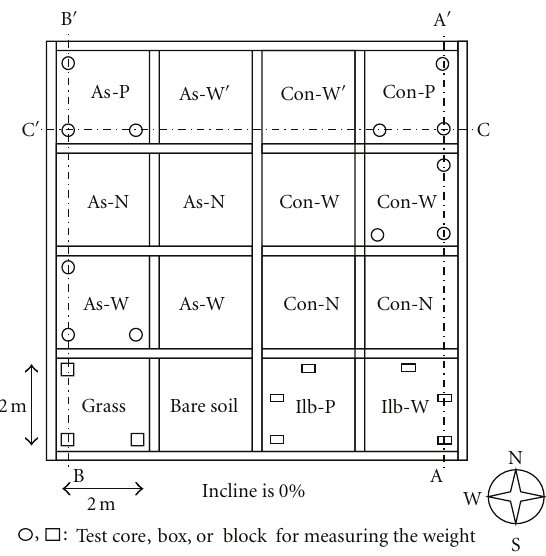
Figure 1: Plan of observation site.